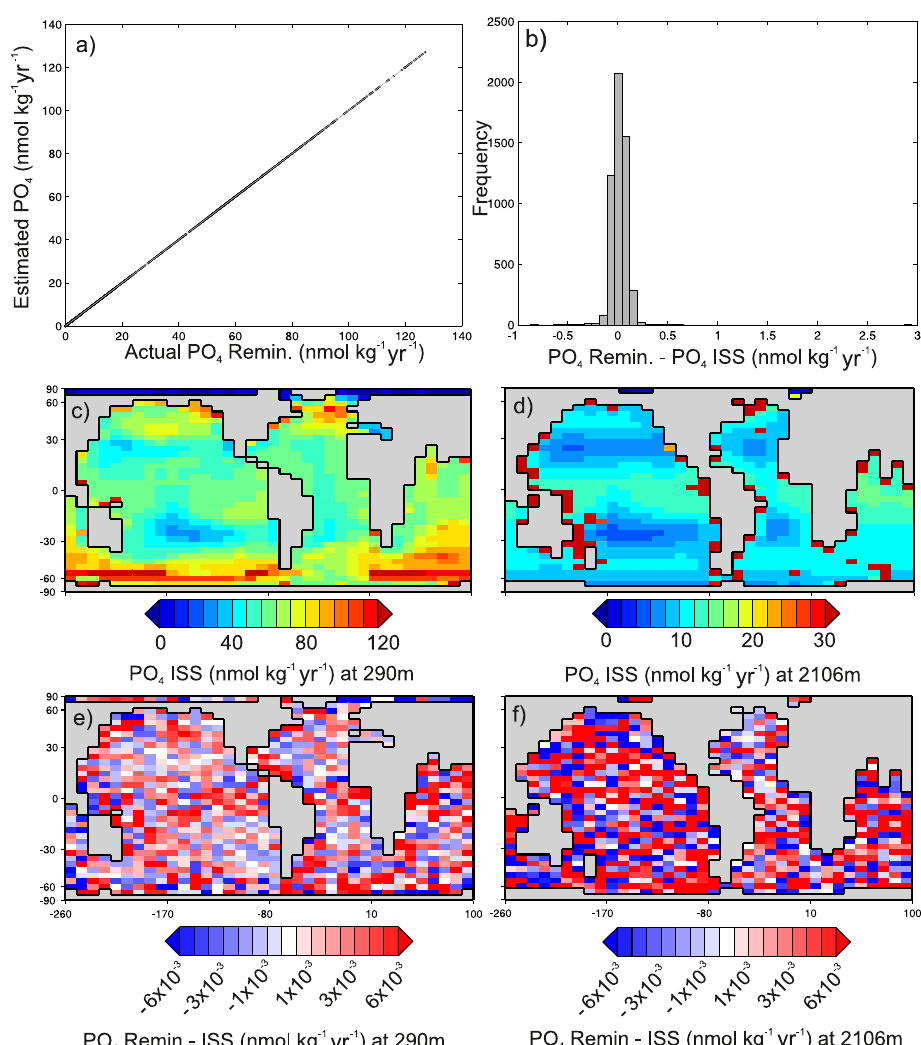
Figure 4. Results from inverting the synthetic data set with its corresponding transport matrix. (a) The interior source/sink estimate for PO 4 when inverting the synthetic [PO 4 ] field with the corresponding transport matrix vs. the synthetic PO 4 remineralisation with a 1 : 1 ratio line. (b) The distribution of errors for the PO 4 interior source/sink estimates (50 bins sized 0 . 15 × 10 − 5 ). (c) The interior source/sink estimate for PO 4 at 290 and (d) 2106m. (e) Difference between inverse interior source/sink estimates and the synthetic remineralisation field at 290 and (f) 2106m. Fig. 5c, both with separate linear trends that correspond well with the size of the “flux-out” term of the TM (i.e. the flux of tracer associated only with ocean transport; see Table 1). The colour scale gives an indication of the relative size of the flux out for each grid box due to circulation. Where the